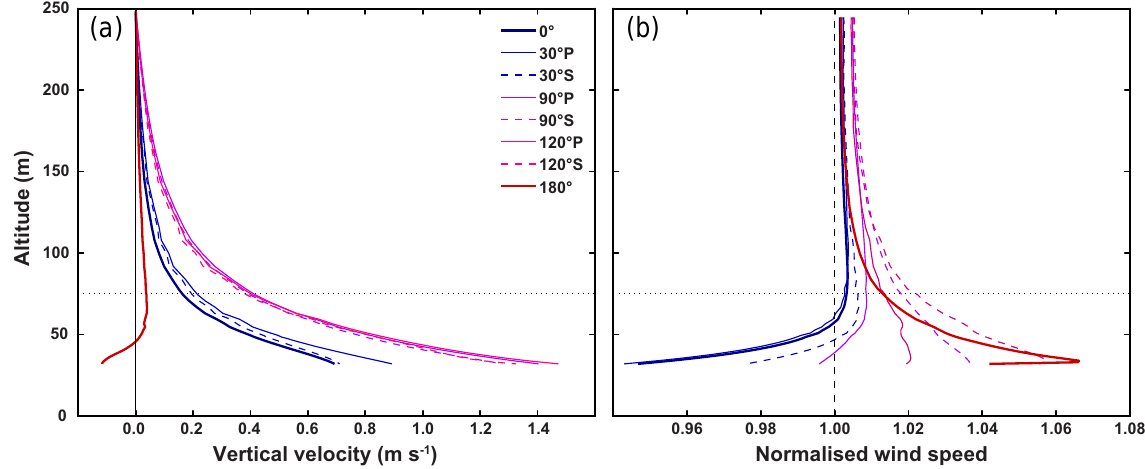
Figure 9. CFD study results for U 10 = 7ms − 1 , above the shipboard lidar location: (a) profiles of vertical velocity above the lidar for various wind directions (port and starboard, relative to the bow). (b) Profiles of the horizontal wind speed, normalised by the free-stream profile for various wind directions (port and starboard) with respect to the bow. The horizontal dotted line indicates 75m above the surface, the lowest level of reliable Doppler velocity measurements. Data are shown only for altitude > 31 . 5m, the approximate level of the first lidar range